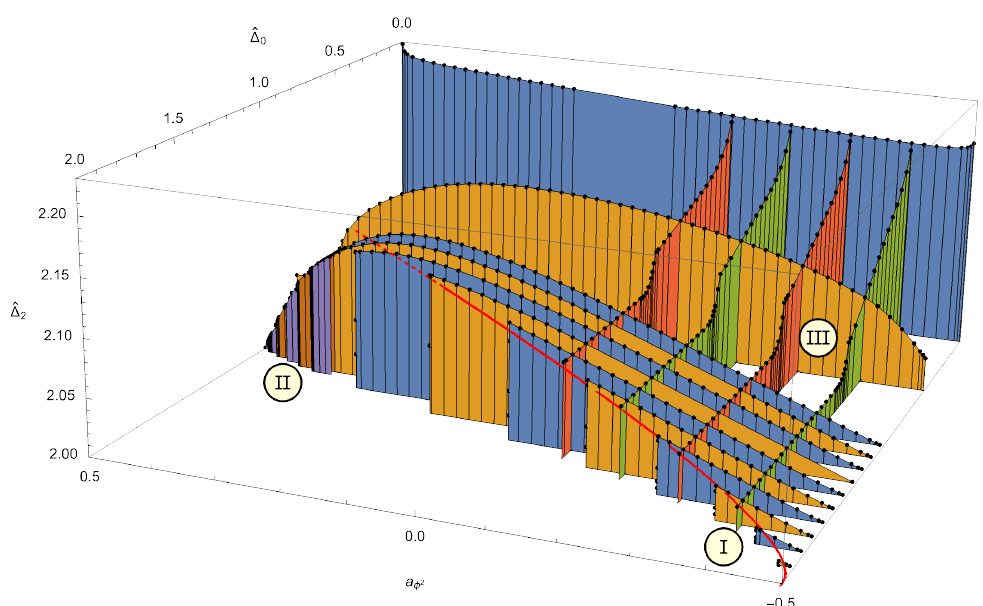
Figure 1. Overview plot of our main numerical results. We plot the maximal gap in the spin 2 sector as a function of a and the assumed gap in the scalar sector. (Note the reflected axis for a φ 2 which decreases when moving to the right.) We find noteworthy structure in the three indicated regions. The red line is the perturbative result of subsection